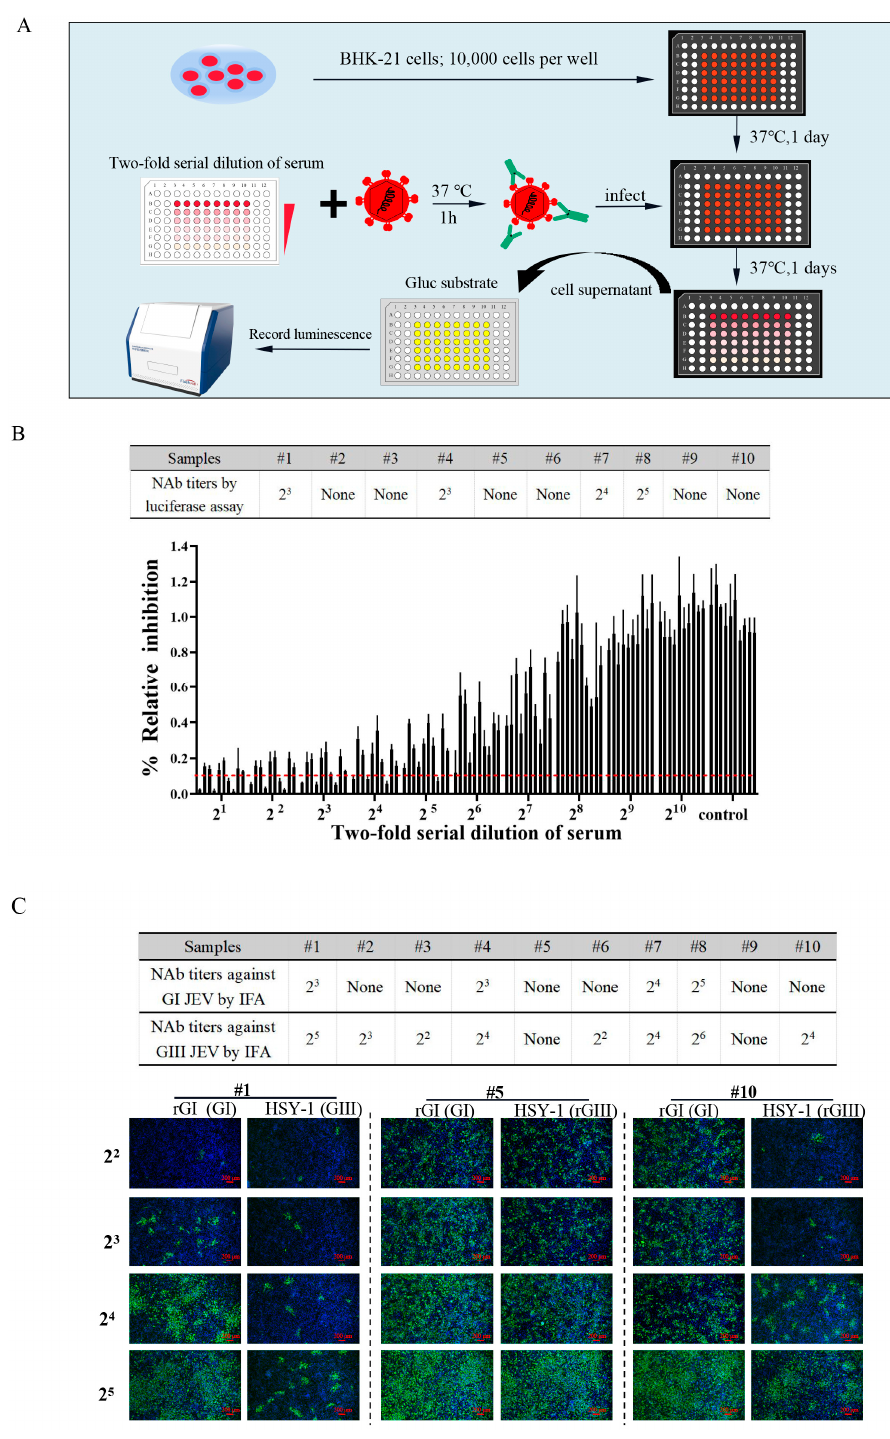
Figure 4. Application of Gluc-tagged GI JEV in the neutralization assay. ( A ) A schematic diagram of the procedure for serum neutralization assay based on Gluc readout. ( B ) The titers of neutralizing antibodies in mice serum samples. Inactivated two-fold serially diluted serum was mixed with an equal volume of rGI-Gluc at the dose of 200 TCID50. After 1 h incubation at 37 ◦ C, the mixture was added to BHK-21 cell monolayers in a 96-well culture plate and incubated for an additional 1 h at 37 ◦ C. At 24 hpi, the cell supernatants were harvested and subject to luciferase assay. Each data point represents the mean ± SD from three experiments. ( C ) The NAb titers against rGI (GI) and HSY-1 (GIII) in mice